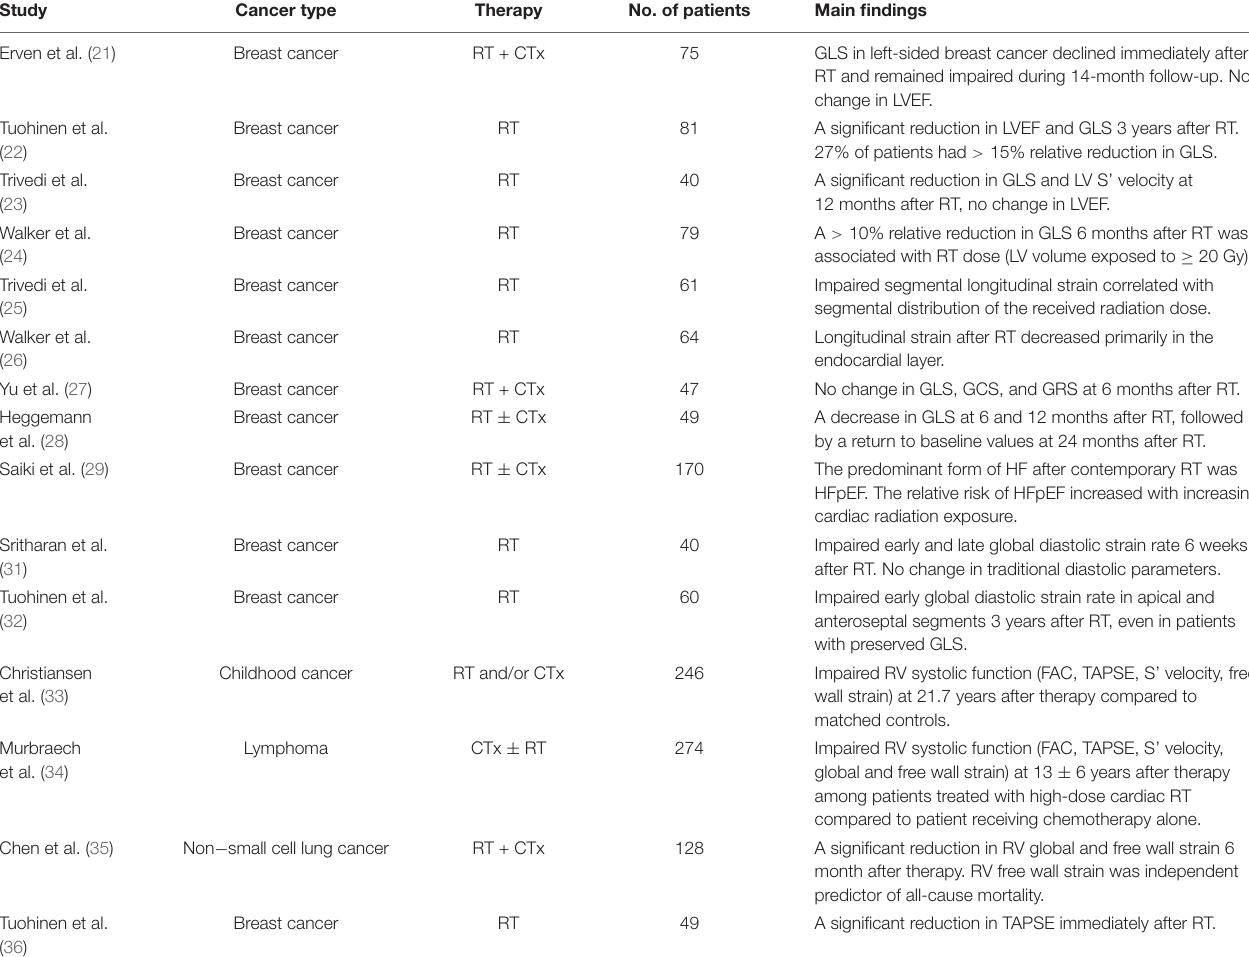
TABLE 1 | Echocardiographic studies to detect RT-induced